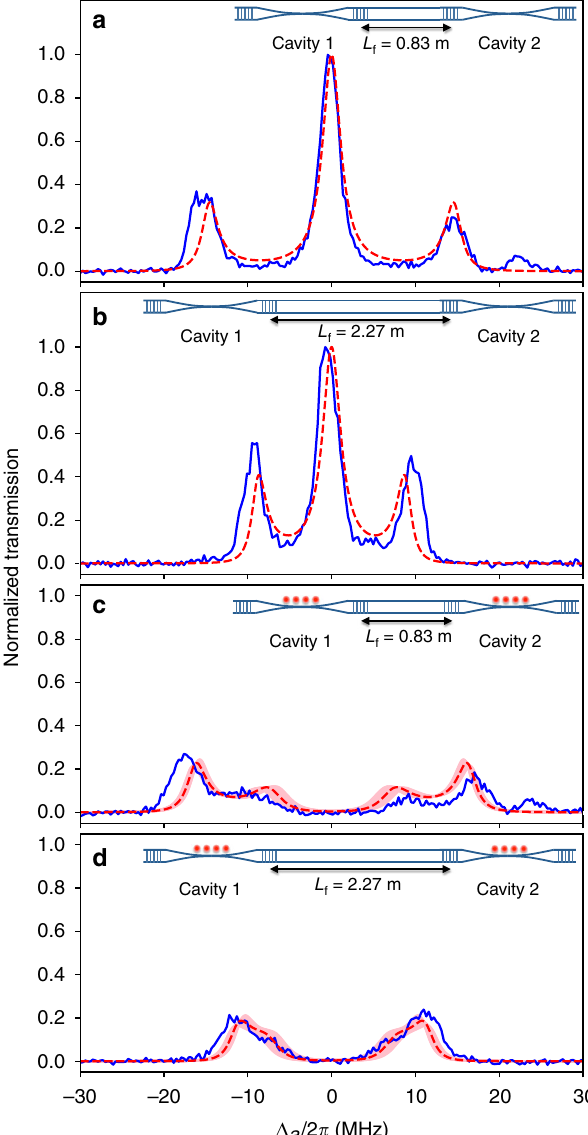
Fig. 3 Transmission spectra with different connecting- fi ber lengths. Blue solid lines represent experimental data, while red dashed lines and pink shaded bands are theoretical curves for ( g 1,eff , g 2,eff ) = 2 π × (7.2, 7.3) MHz and ( g 1,eff , g 2,eff ) = 2 π × (7.2 ± 1.0, 7.3 ± 1.0) MHz, respectively. The small peaks at Δ a ≈ 2 π × 25 MHz in ( a , c ) correspond to a mode with different polarization, which appears because of imperfect polarization compensation in the connecting fi ber (see Supplementary Note 2). The dependence of the cavity- fi ber coupling rates v 1 and v 2 on the connecting- fi ber length is clearly observed as the change of the splitting in the triplet structure in ( a , b ). In contrast, the splitting of the central peak in ( c , d ) remains unchanged. This is because the coupling rate between atoms and the delocalized photons in the fi ber-dark mode does not depend on the connecting- fi ber